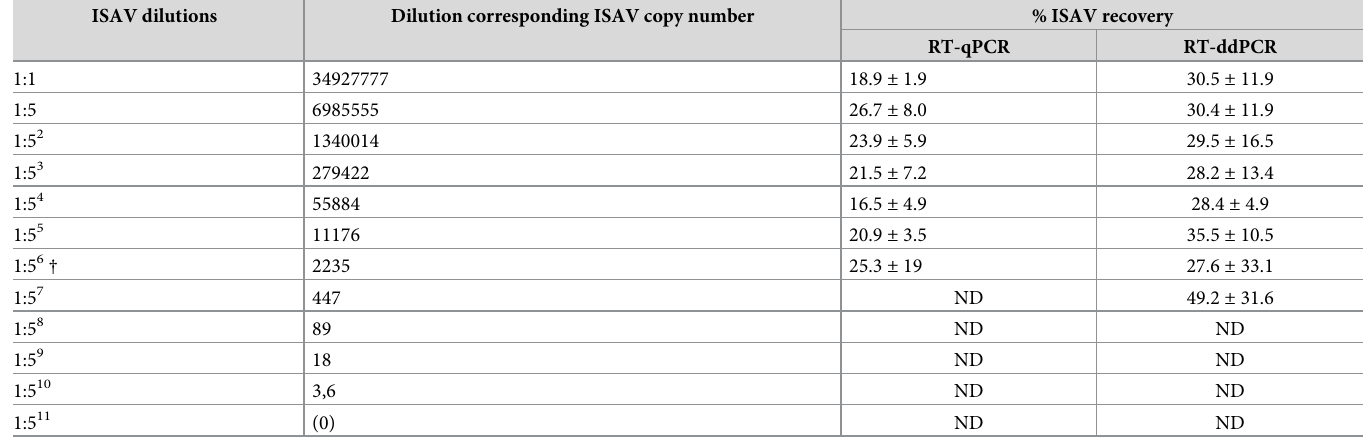
Table 4. Estimation of lower limit of quantification of ISAV in natural seawater. Five-fold serial dilutions of ISAV stock were used to spike different 1L natural seawa- ter samples (1 dilution/each) and the spiked seawater samples were concentrated using the MF-/buffer 1 concentration method. ISAV recovery rate (%) based on RT- qPCR and RT-ddPCR quantification data are presented as mean ± standard deviation from two biological replicates.